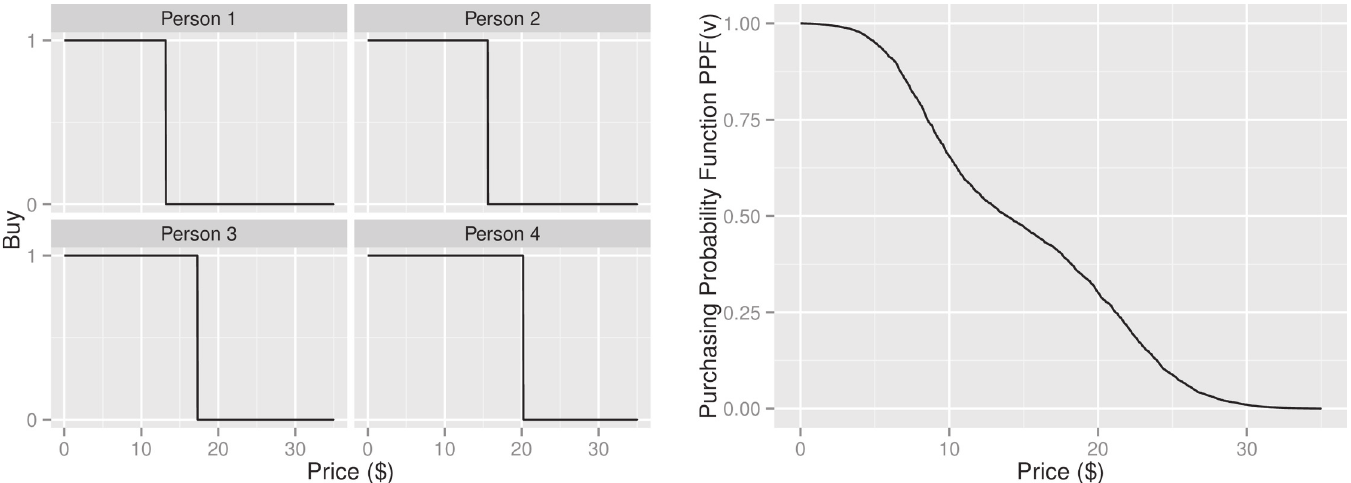
Fig 1. The overall purchasing probability function–(left) for 4 individuals; (right) over a population.